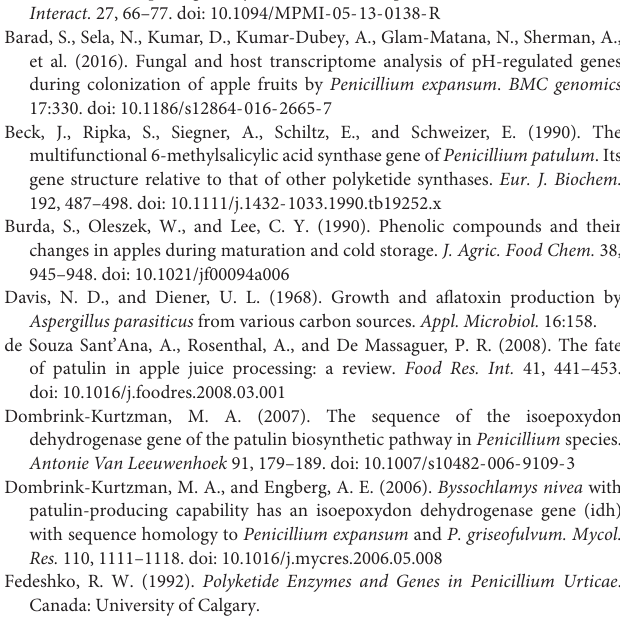
TABLE S1 | Nucleotides used for qPCR